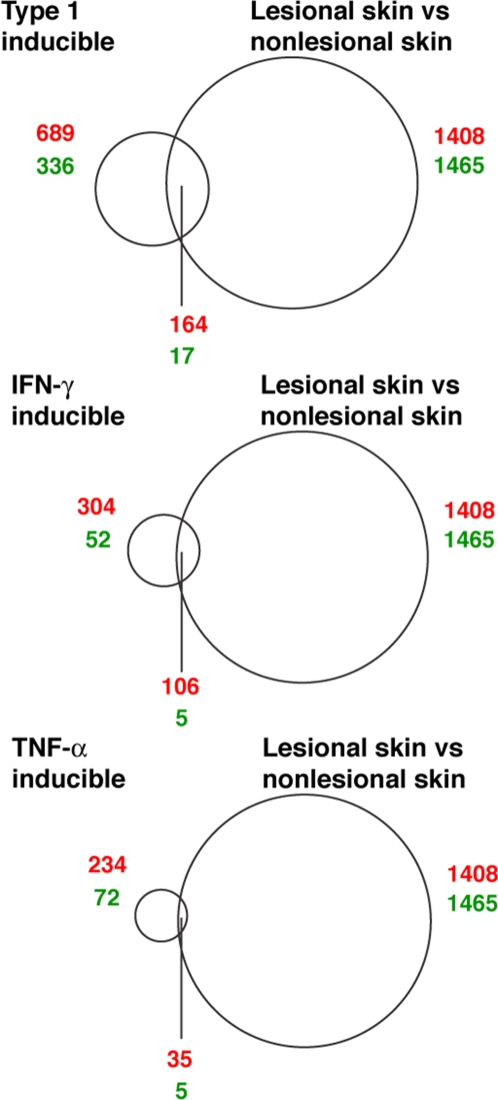
Probe sets common to lesions and ex vivo stimulation.Venn diagrams illustrating both the number of probe sets that are altered by type I IFN, IFN-γ, and TNF-α in ex vivo stimulation of whole blood from healthy donors (left circles) and probe sets that are altered in lesional skin compared with nonlesional skin (right circles). Red numbers: probe sets that show increased expression with cytokine treatment or compared with nonlesional skin baseline. Green numbers: probe sets that show decreased expression with cytokine treatment or compared with nonlesional skin baseline. The intersecting regions represent the probe sets that are common to both comparisons.